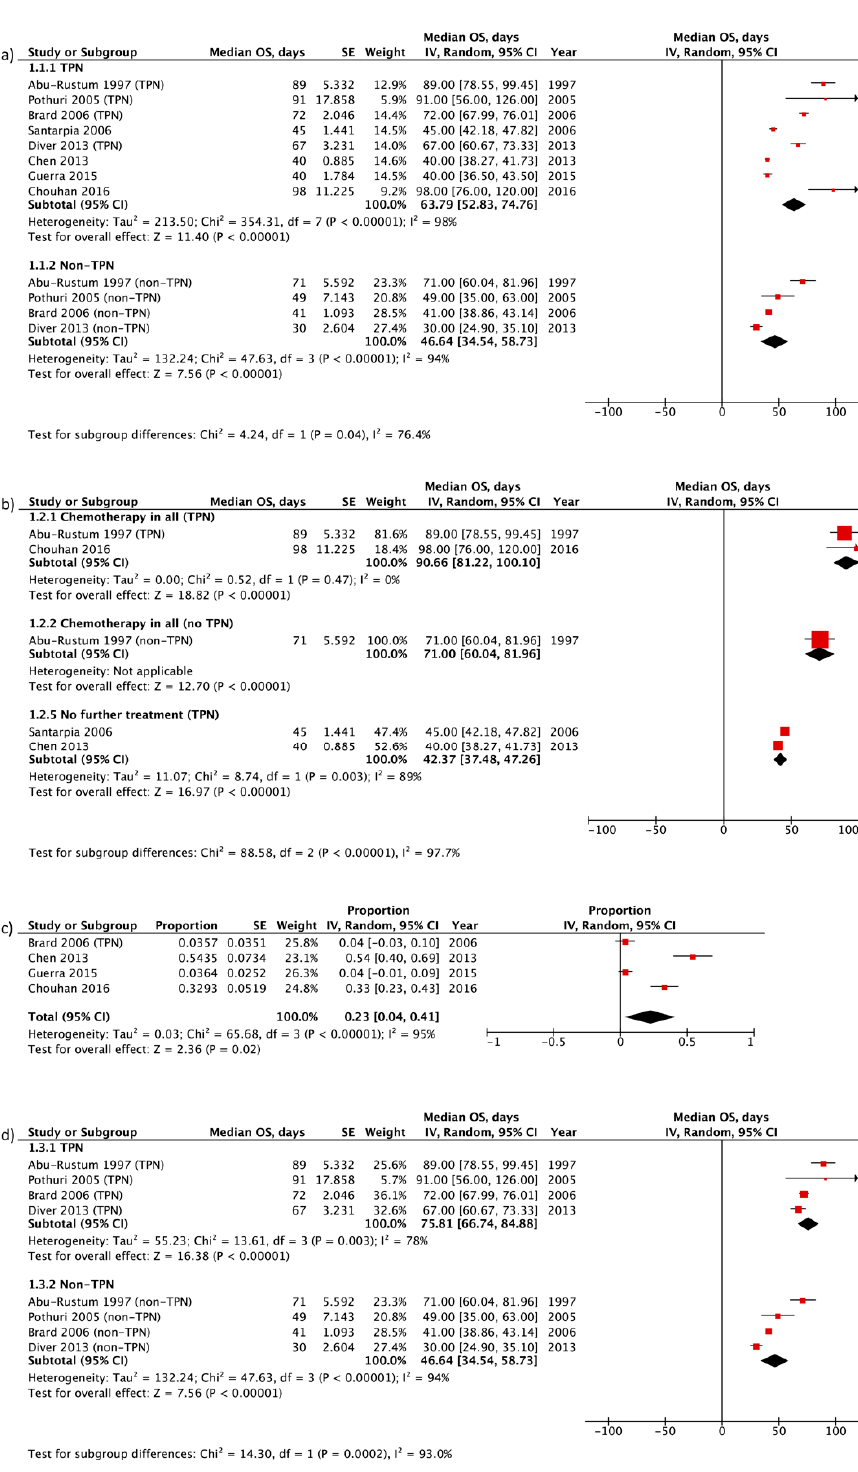
Figure 2. ( a ) Forest plot showing subgroup analysis of the median survival time based on TPN status, i.e., TPN and non-TPN. Pooled subgroup median survival time was compared between TPN and non-TPN groups. ( b ) Forest plot showing subgroup analysis of the median survival time based on TPN status, i.e., TPN and non-TPN among patients receiving chemotherapy. Pooled subgroup median survival time was compared between TPN and non-TPN groups. ( c ) Forest plot showing pooled complication rate with 95% CI. ( d ) Forest plot showing subgroup analysis of the median survival time based on TPN status, i.e., TPN and non-TPN in high-quality studies. Pooled subgroup median survival time was compared between TPN and non-TPN groups. In ( a , b , d ) forest plots, squares indicate the individual median survival time. In ( c ), squares indicate the individual complication rate. In all figures, bars represent 95% CIs of each included study. The size of each square is proportional to the percentage weight of the individual study in the meta-analysis. Black diamonds indicate the pooled median survival time in ( a , b , d ) or pooled complication rate in ( c ) and 95% CI.